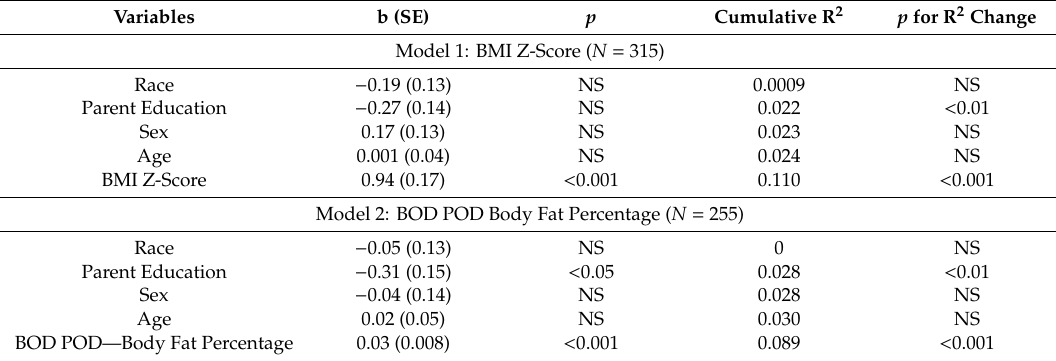
Table 3. Regression Analysis Models Predicting Frequency of Weight-Related